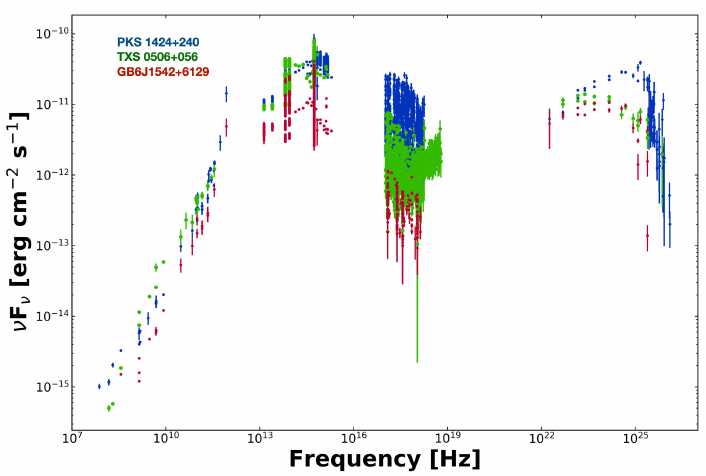
Figure 4. The SED of the three blazars reported as possible neutrino sources in [4]. They are all of the IBL type with remarkably similar flux and overall shape, except in the X-ray band, where small differences in ν S , large variability and non-simultaneous observations cause a large peak